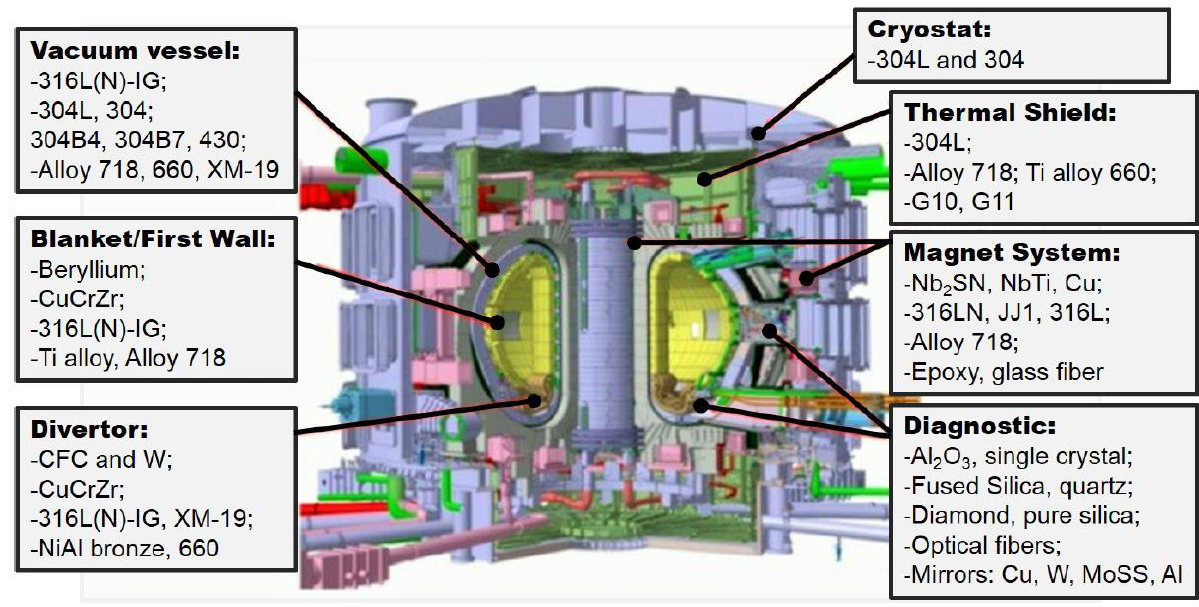
Figure 10. Summary of materials tentatively selected for ITER Tokamak [15]. © 2010 ITER Organization. This image is hereby used courtesy of the ITER Organization.